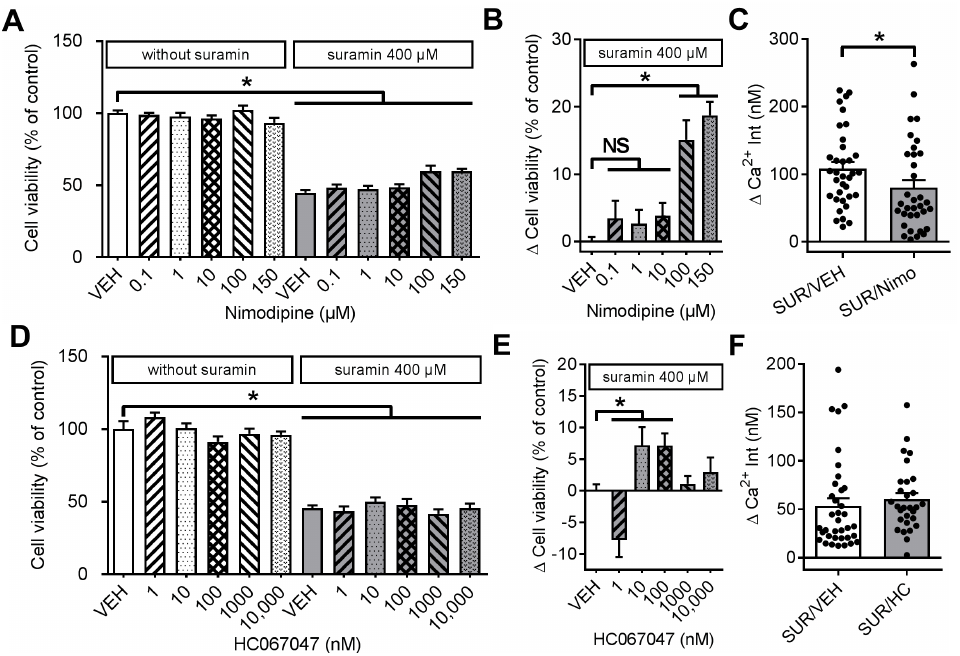
Figure 3. Effects of nimodipine and HC067047 on cell viability and intracellular Ca 2+ in DRGN. ( A ) Treatment of DRGN for 24 h with suramin (400 µM) significantly decreased cell viability. Co-